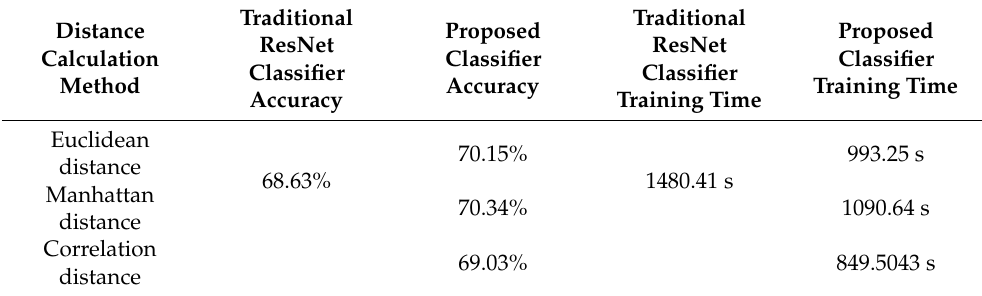
Table 5. Performance of proposed method using different distance calculation